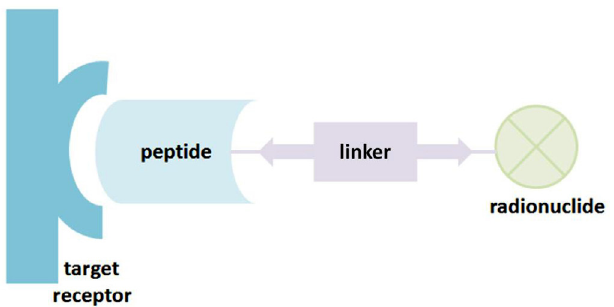
FIGURE 5 - Schematic representation of strategy to target receptor with peptide radiopharmaceutical (Adapted from Okarvi,